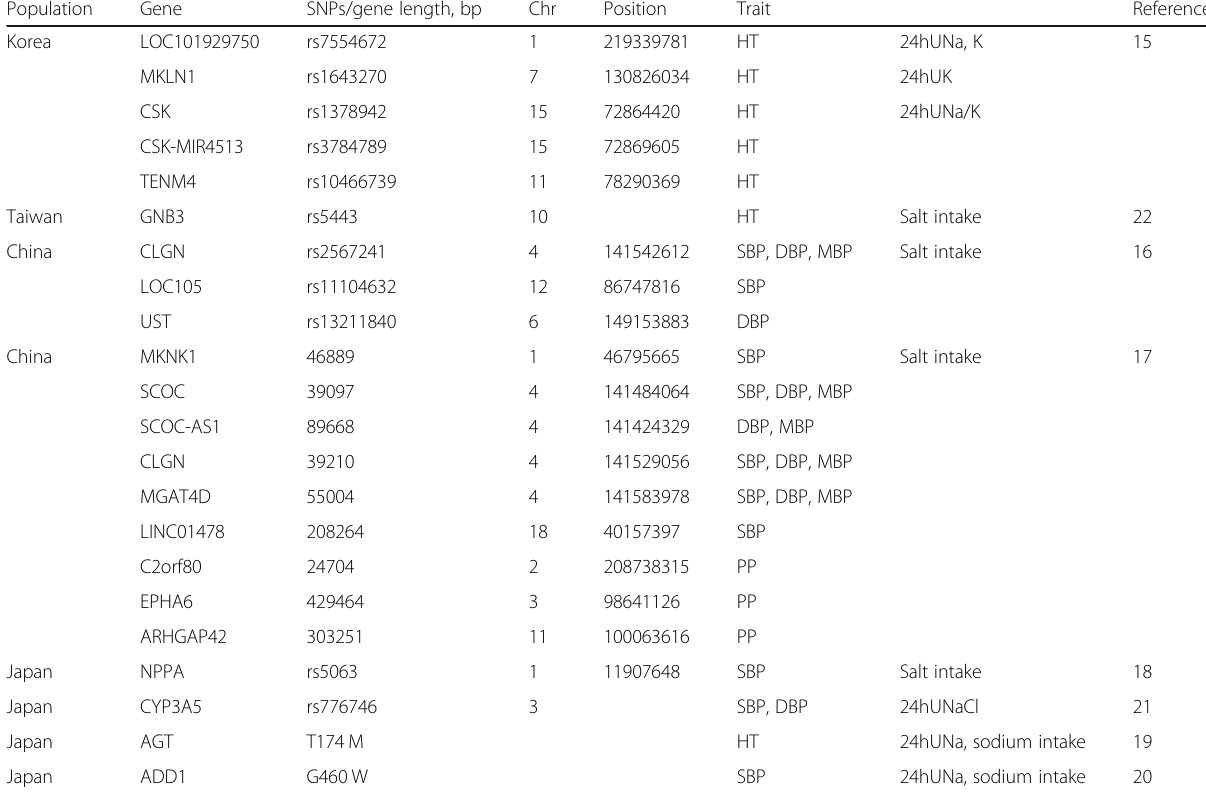
Table 2 Review for interaction of gene and salt intake on hypertension